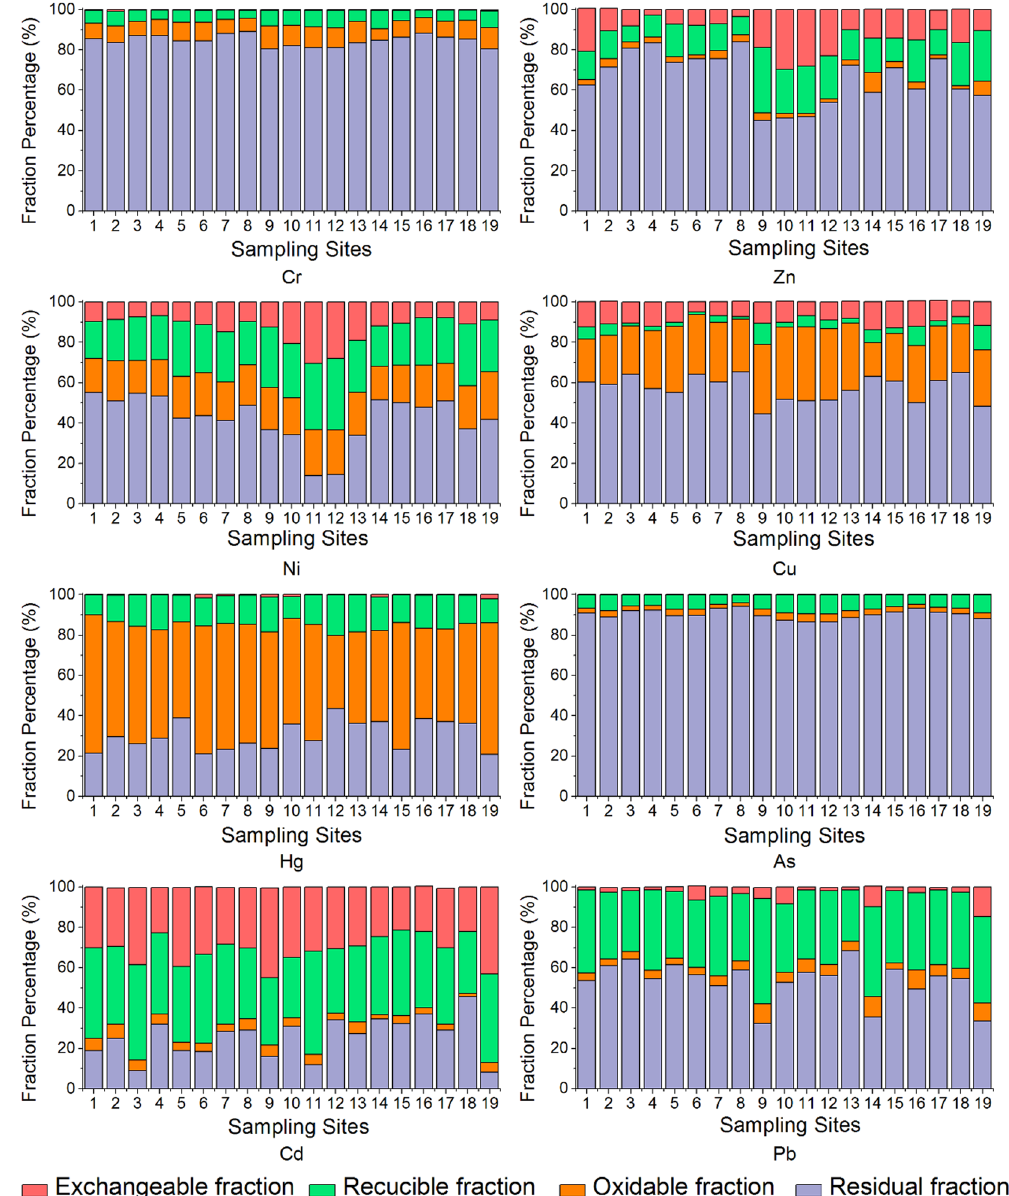
Figure 3. Chemical fractions of heavy metals in the sediment